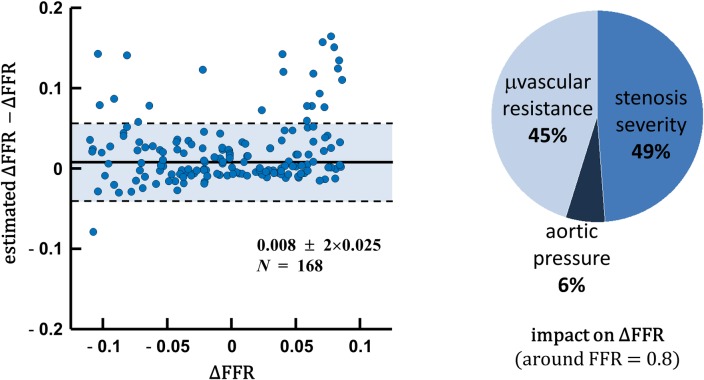
FFR variations around 0.8.Left panel: estimated vs. actual FFR variations around the 0.8-threshold value (Eq 5). Right panel: respective impacts of hyperemic microvascular resistance, stenosis severity and aortic pressure on FFR variation.